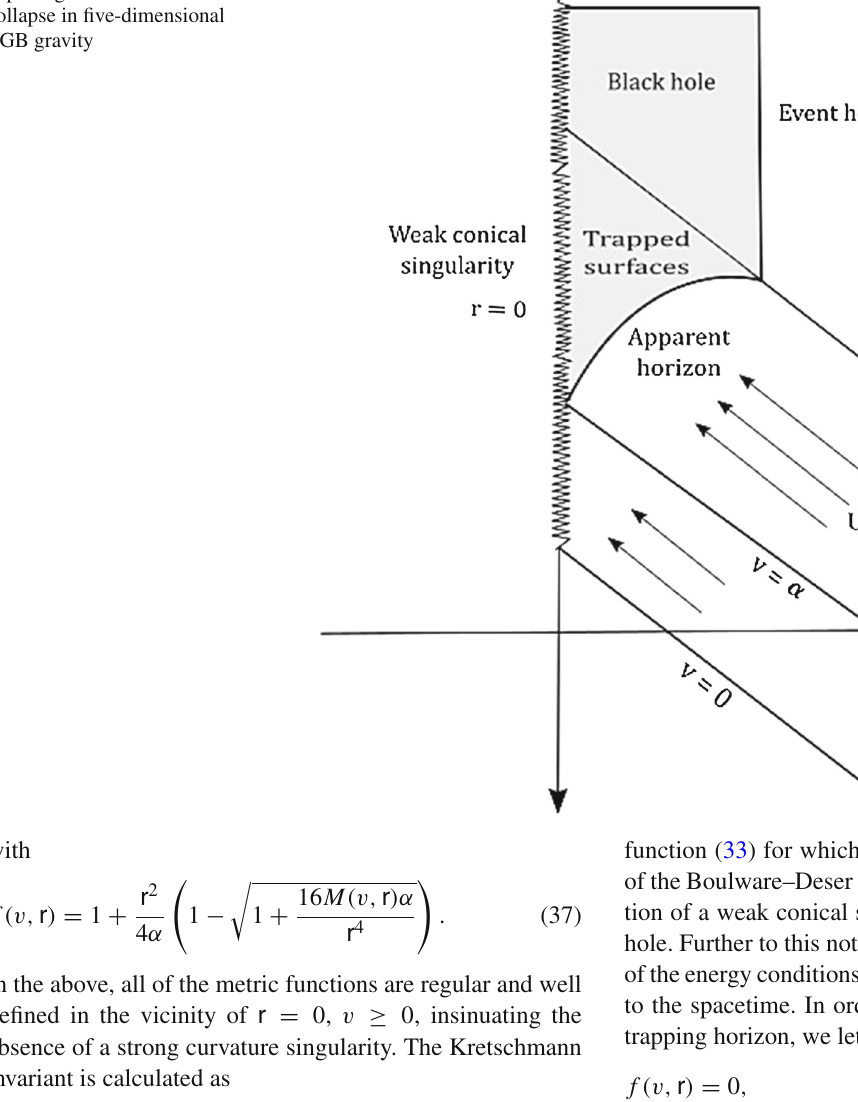
Fig. 6 Spacetime diagram depicting radiation shell collapse in five-dimensional EGB